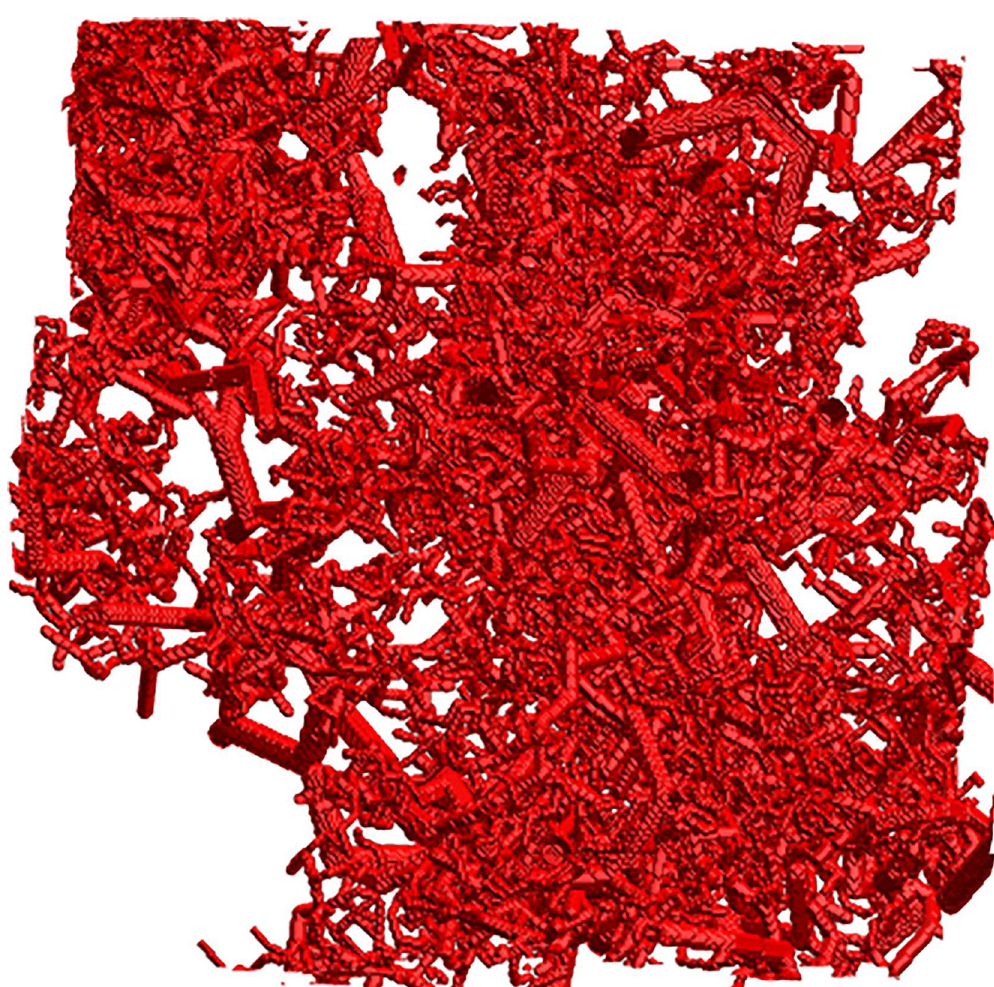
Fig 5. Microvascular network section. A 3x3x3 mm 3 section of the completemicrovascular network used in the combinedtree